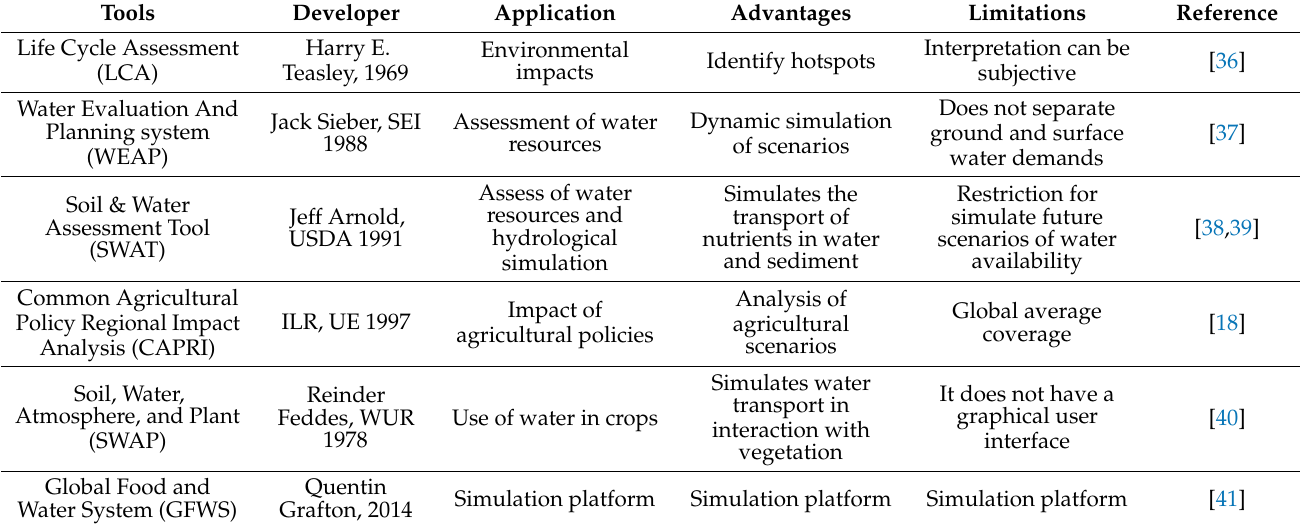
Table 2. Background of models adapted in case studies to assess the Water–Food